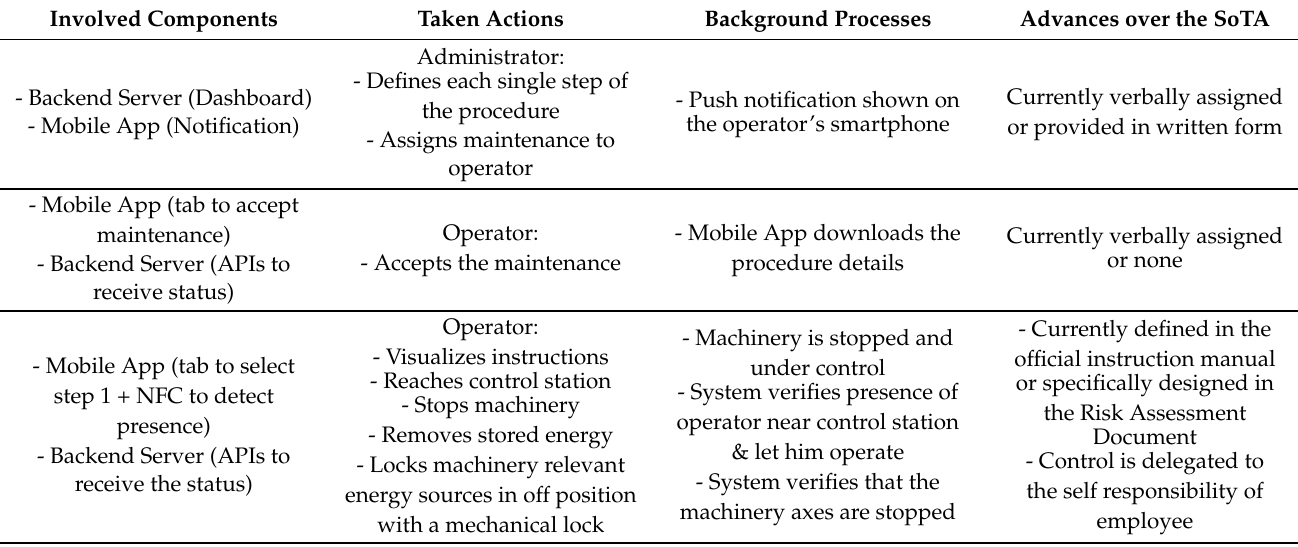
Table 1. Steps followed during a maintenance